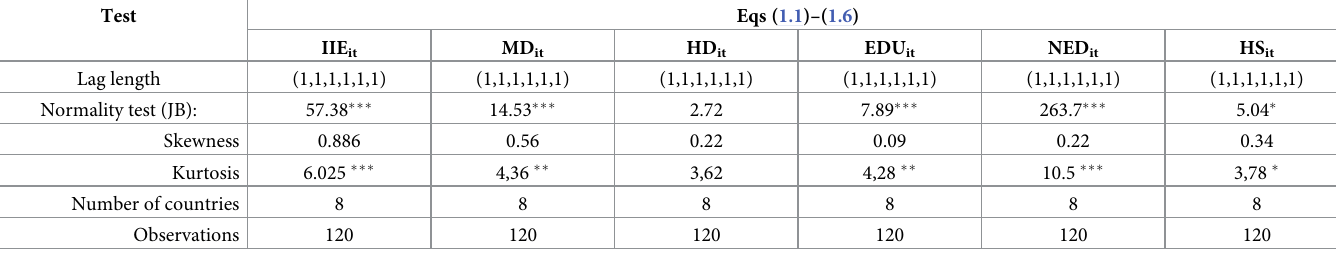
estimator we used is a popular method for estimating dynamic panels with different short-run coefficients and error variances across individuals. For built ARDL models, the JB test for the normality of the residuals distribution was calculated. The results of tests are presented in Table 3. Residual diagnostics in all equations show that all instruments used in panel ARDL models are valid. However, based on normality test, we concluded that the residuals of the four Table 3. Residual diagnostic of empirical